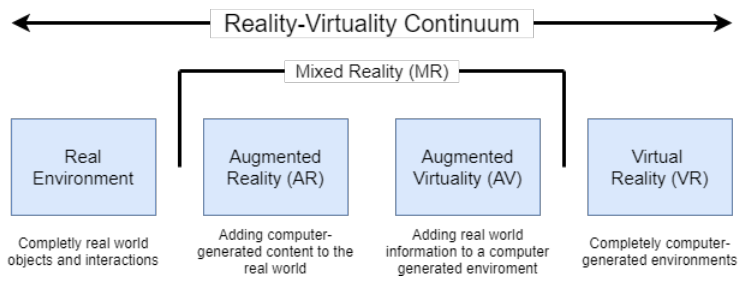
Figure 1. Reality–virtuality